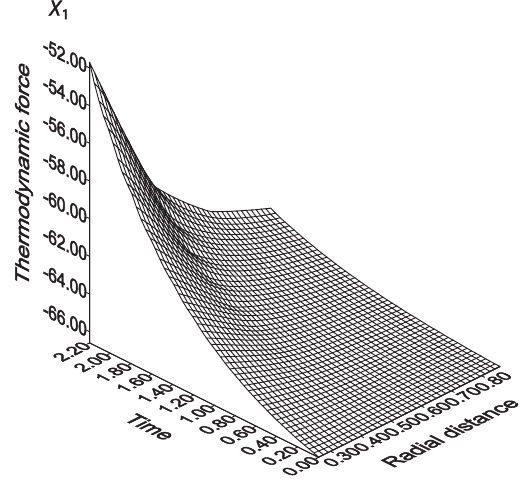
Figure 4.8 . Variation of the thermodynamic force X distance and